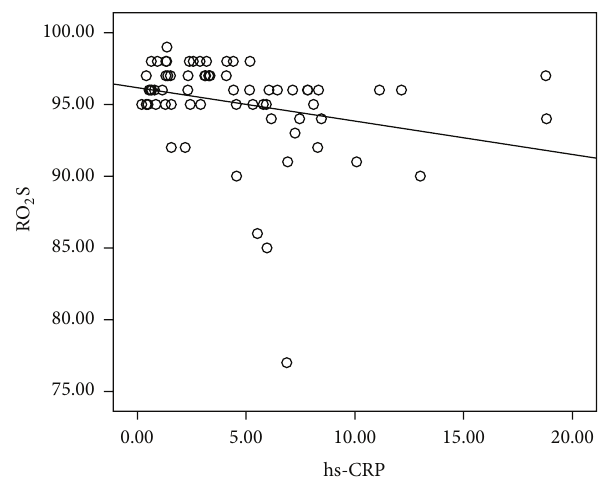
Figure 5: Relationship between serum high-sensitivity C-reactive protein (hs-CRP, mg/L) levels and RO 2 S% (rest oxygenation satura- tion under room air) in patients with stable bronchiectasis ( 𝑛 = 69 , 𝑟 = −0.269 , 𝑃 = 0.025 by Pearson’s correlation).